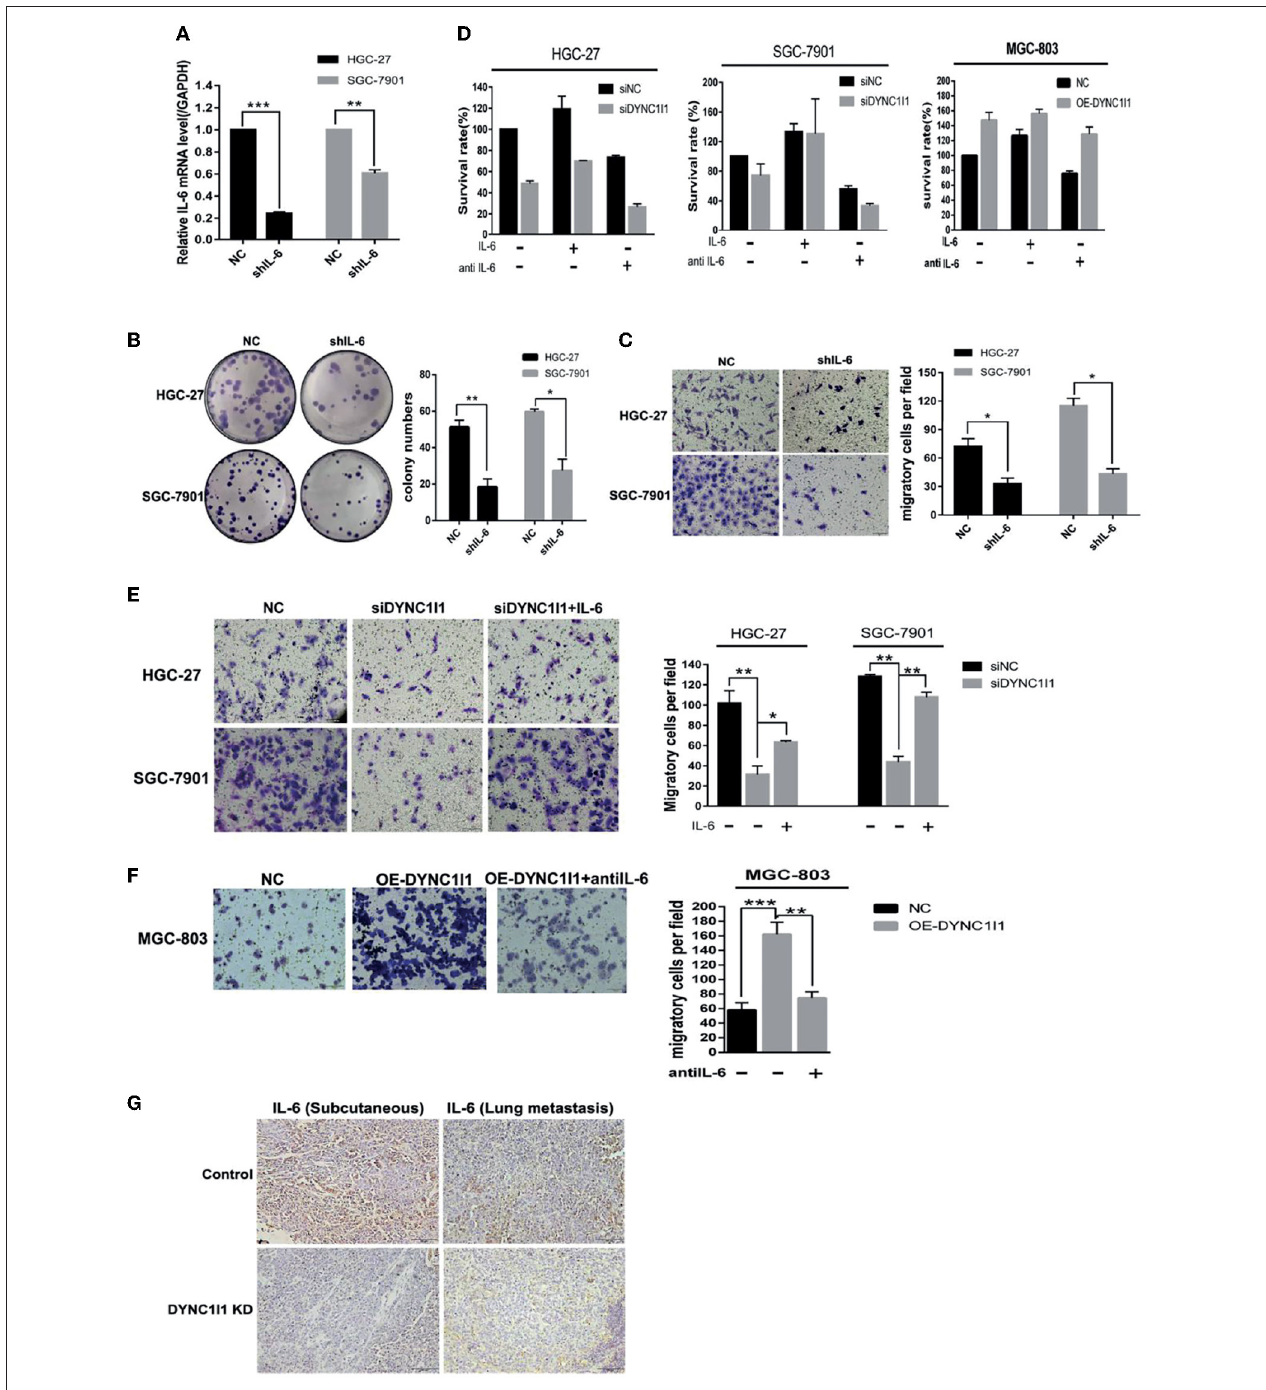
FIGURE 6 | DYNC1I1 promotes proliferation and migration of gastric cancer cells through IL-6. (A) RT-qPCR shows IL-6 transcription levels after knockdown IL-6 gene by using shRNA for 48h. (B) Colony formation shows gastric cancer cells form colony ability after knocking down IL-6. (C) Transwell assays displays the change in migration of gastric cancer cells after knocking down IL-6 or not. (D) MTT shows proliferation ability of gastric cancer cells after adding IL-6 or IL-6 neutralizing antibody after knocking down or overexpression DYNC1I1. Add IL-6 or IL-6 neutralizing antibody 48h after knocking down DYNC1I1. (E) Transwell assays shows the change in migration of gastric cancer cells after adding IL-6 after knocking down DYNC1I1. (F) Transwell assays shows the change in migration of gastric cancer cells after adding IL-6 neutralizing antibodies after overexpression DYNC1I1. (magnification × 200) (G) Immunohistochemical detection of IL-6 expression in subcutaneous and lung metastatic tumors of mice tumor tissue(magnification × 100). (* P < 0.05, ** P < 0.01, *** P < 0.001, n = 3, student t -test, means ± 95% CI).